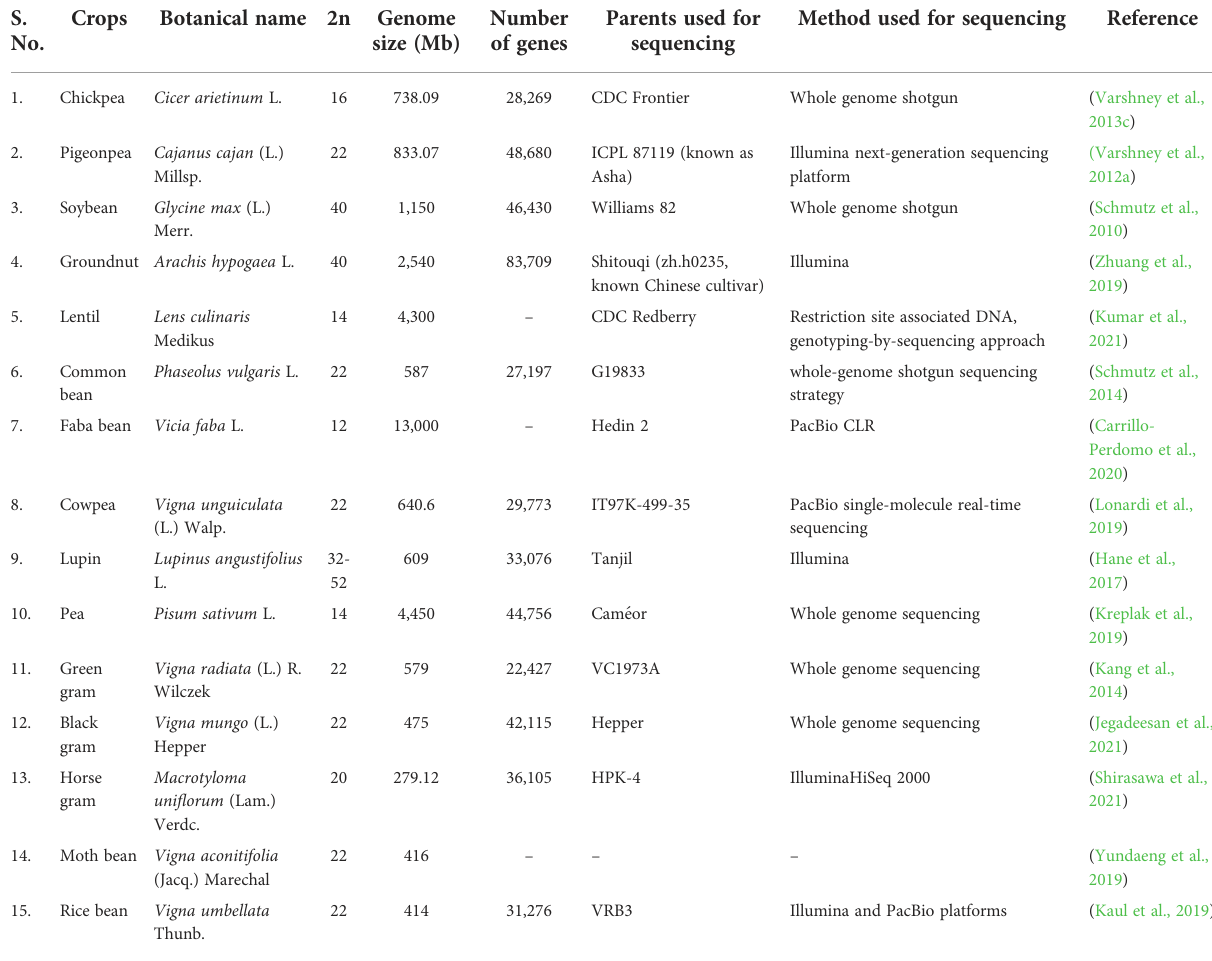
TABLE 1 List of legume crops with their genomic